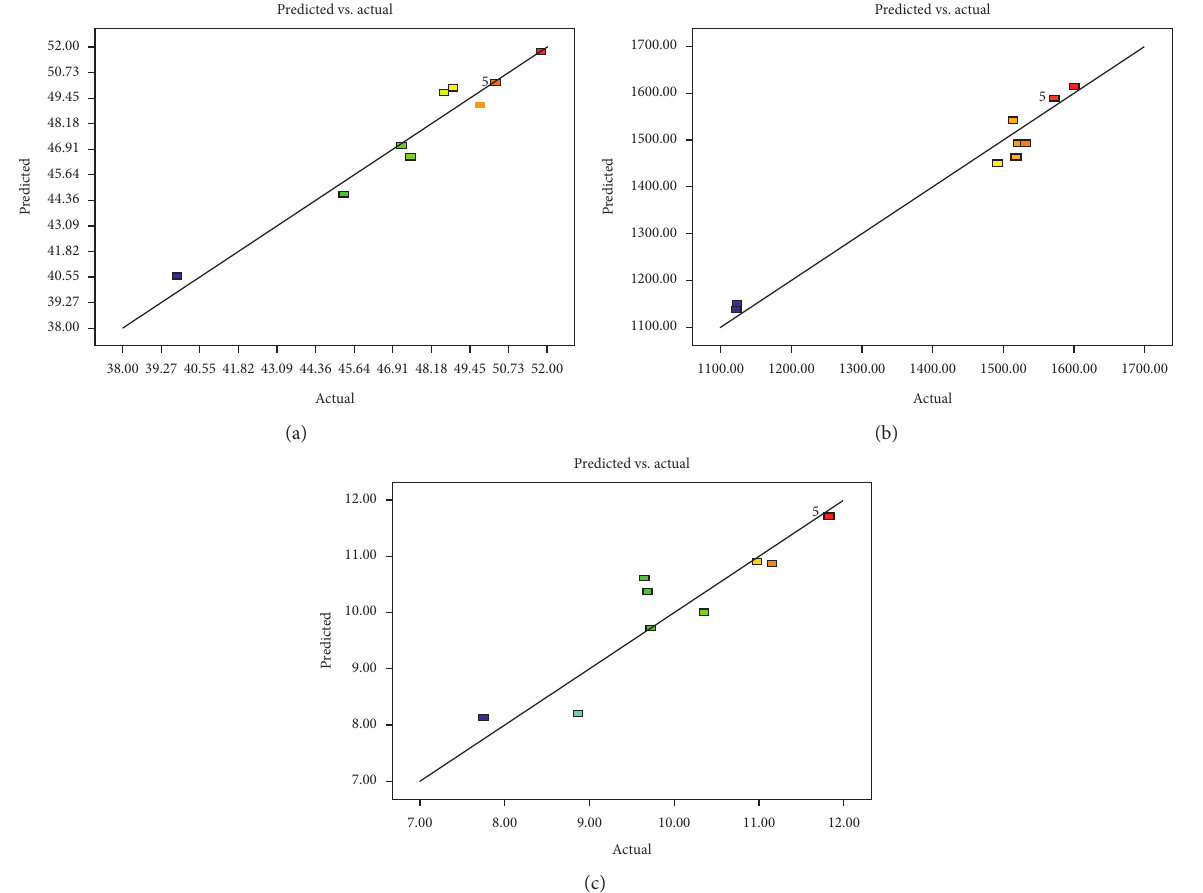
Figure 7: Comparisons of the predicted and experimental values: (a) quenching hardness H , (b) tensile strength σ , and (c) elongation δ